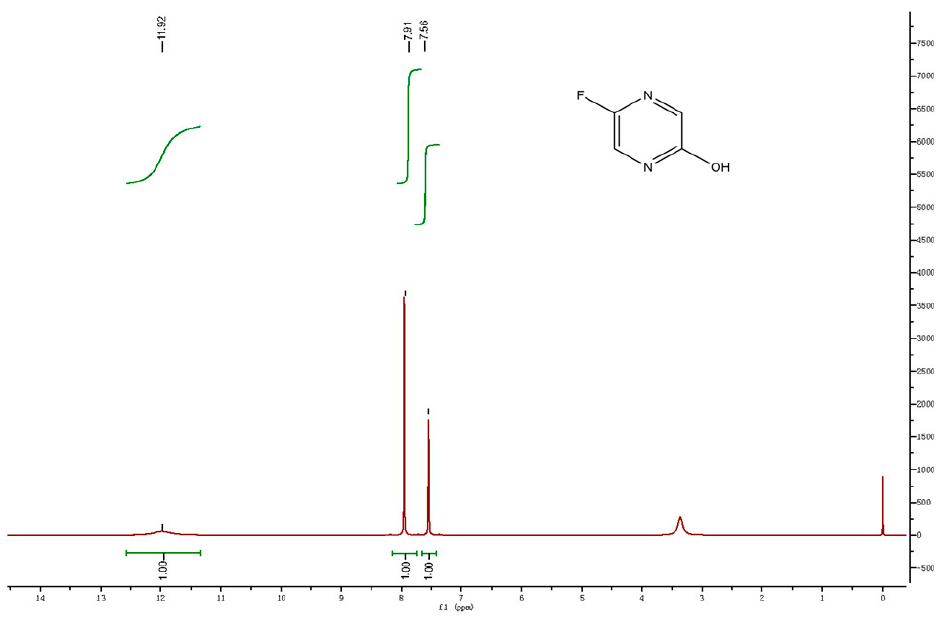
Figure 7. 1 H NMR of the isolated alkali degradation product.